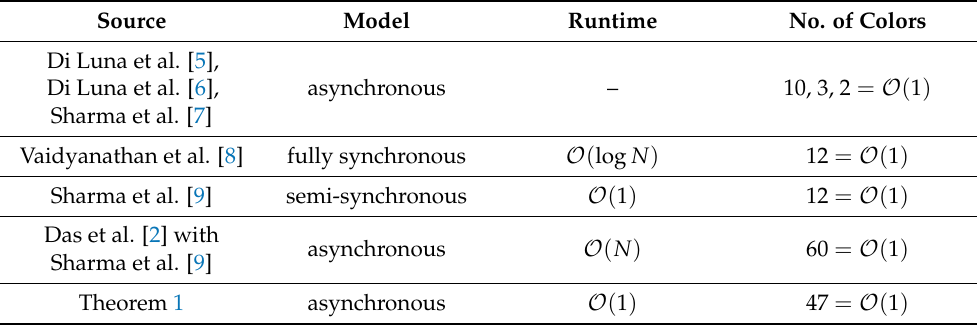
Table 1. Comparison of C OMPLETE V ISIBILITY results for the robots with lights model with monotonic movements on a 2-dimensional Euclidean plane. Source Model Runtime No. of